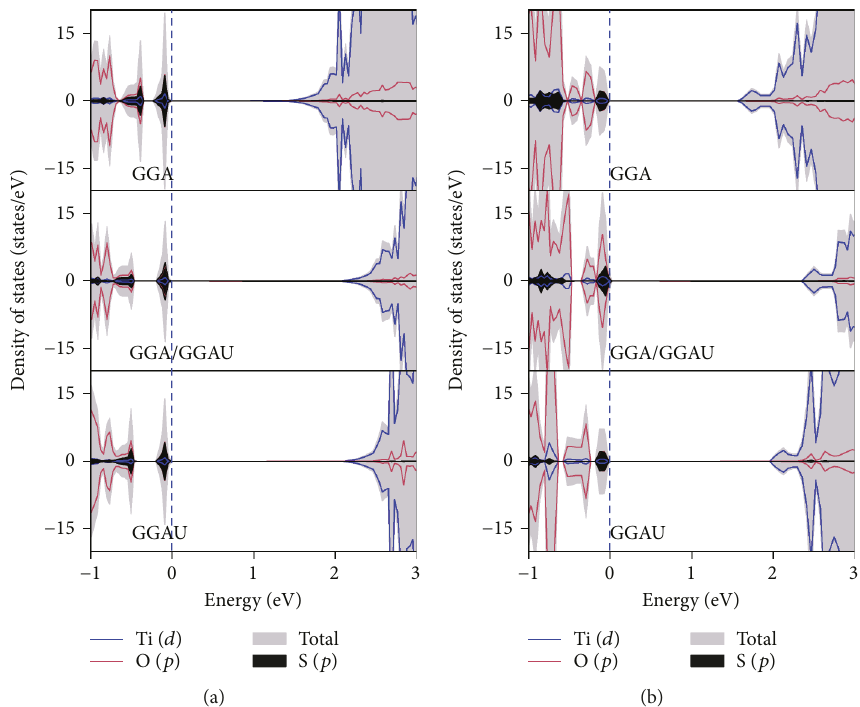
Figure 5: The total and partial density of states of the three relaxation methodologies for S-doped anatase TiO (b) The TiO (101) surface. 2 Table 1: Summary of bandgaps ( E ) for the bulk and surface models for all doped and pristine TiO g Bulk Surface Dopant GGA